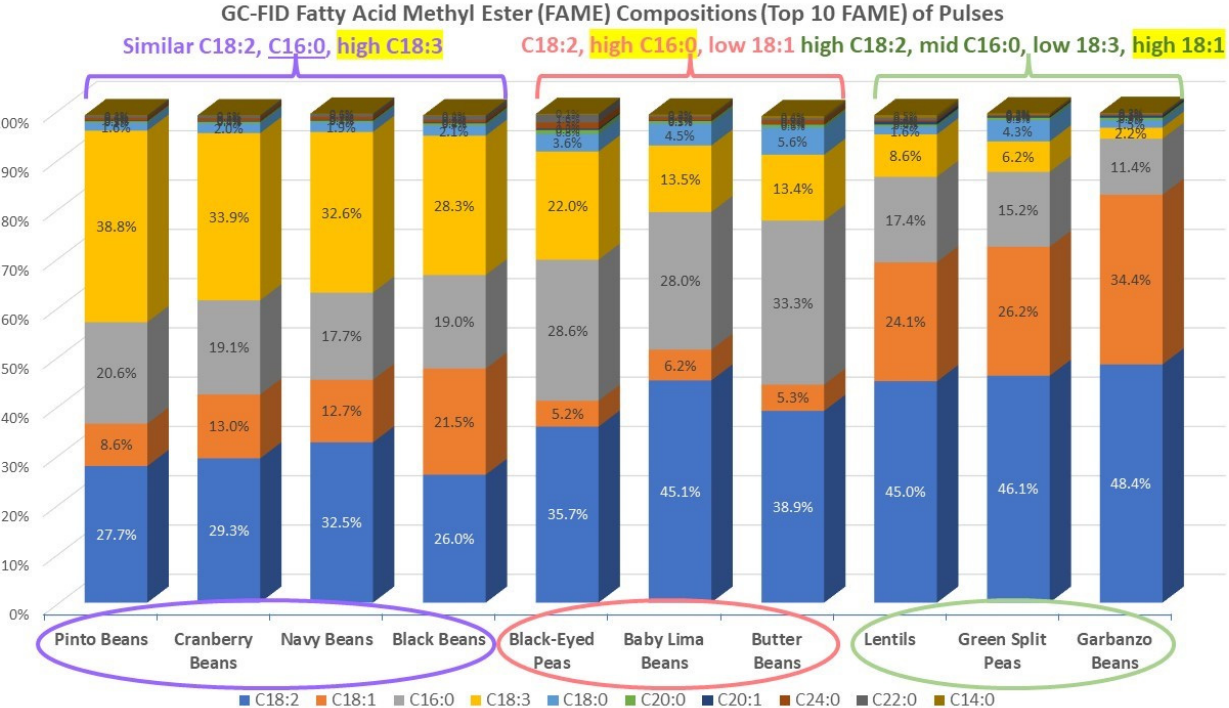
Figure 1. Stacked bar chart showing the percentages of the ten most abundant FA, on average, of the ten pulse samples. The samples are arranged in order of decreasing percentage of 18:3, from left to right. Colored ovals correspond to groups in Fig. 2.